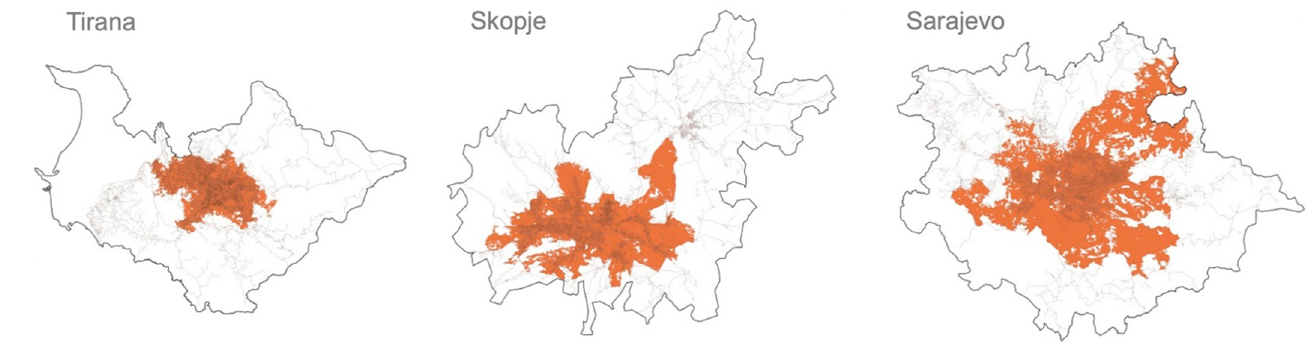
Figure 5. A map defines the urban and peri-urban boundaries for Tirana, Skopje, and Sarajevo.